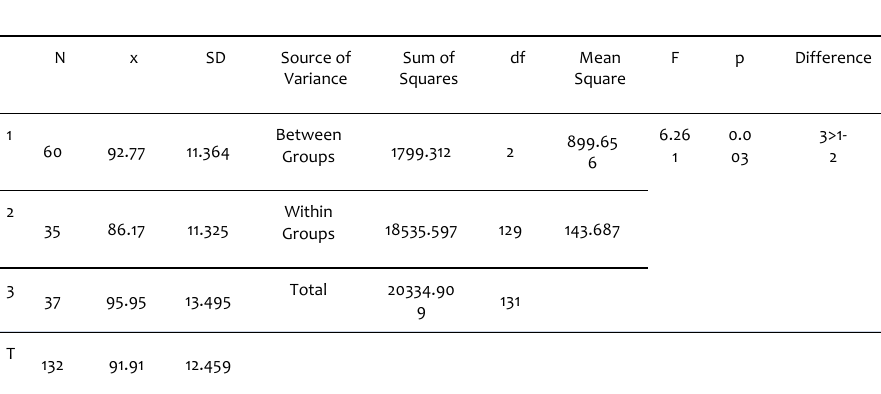
Table 14. Students' reading motivation scores in relation to academic